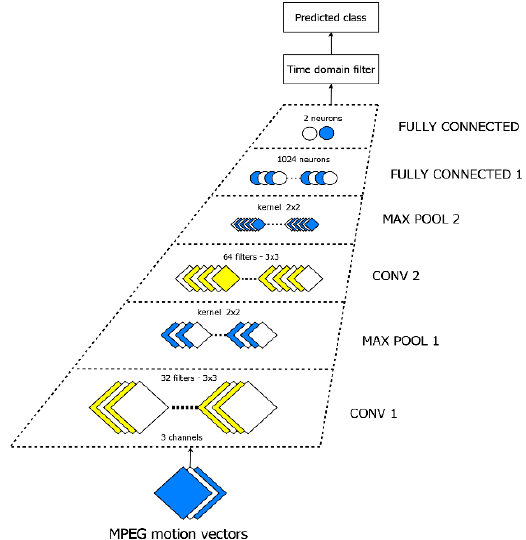
Figure 4. The classifier architecture.